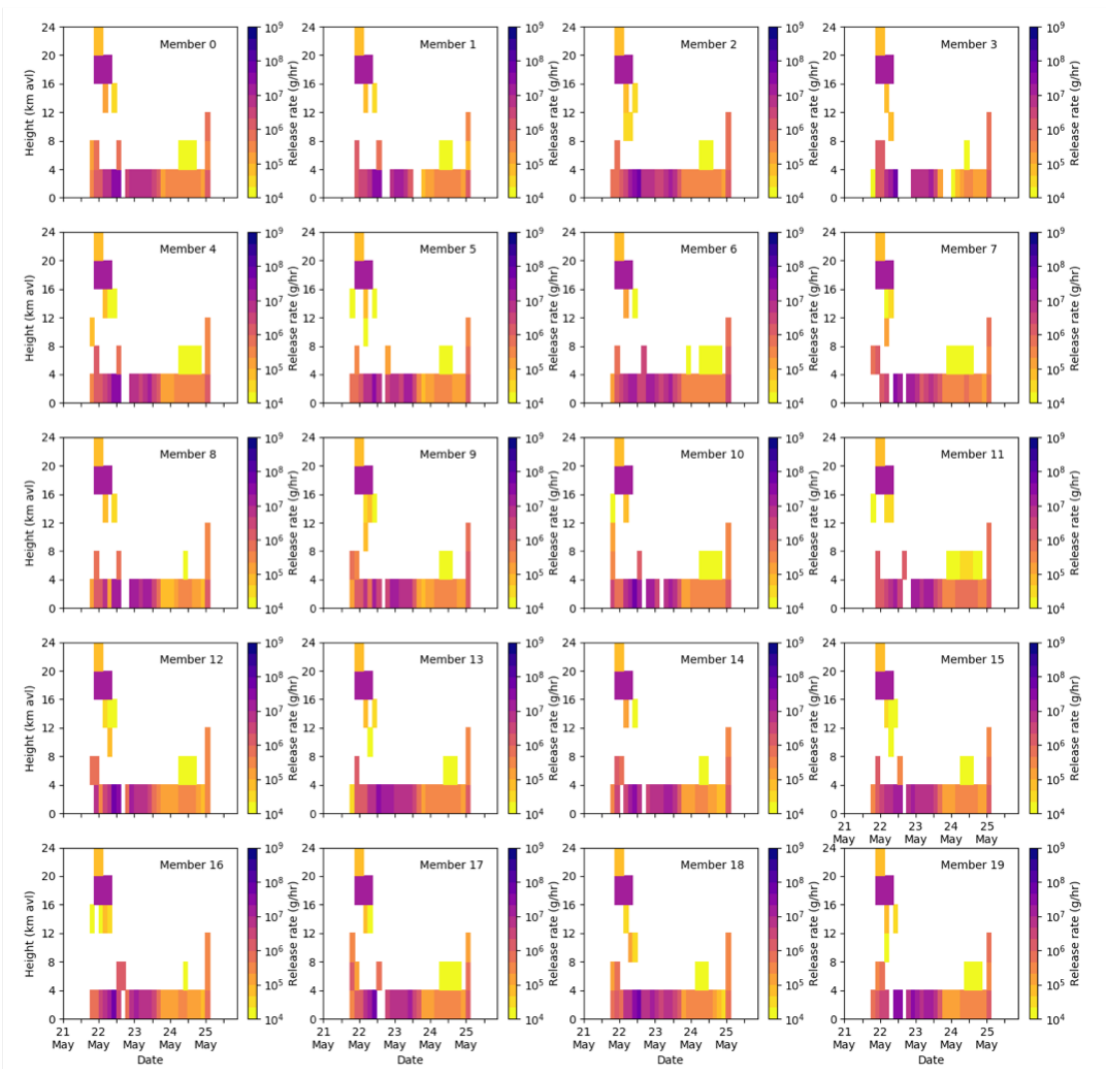
Figure 4. Posterior emission profiles (g/h) estimated by InTEM for the 2011 Grímsvötn eruption for each member of the ECMWF EPS ensemble using SEVIRI retrievals of ash and clear skies. Note the logarithmic color